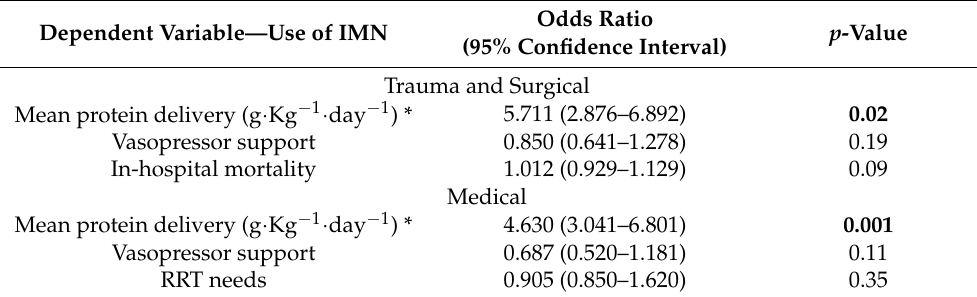
Table 6. Multivariate analysis—variables associated with the use of immunonutrition in trauma and surgical and medical patients.